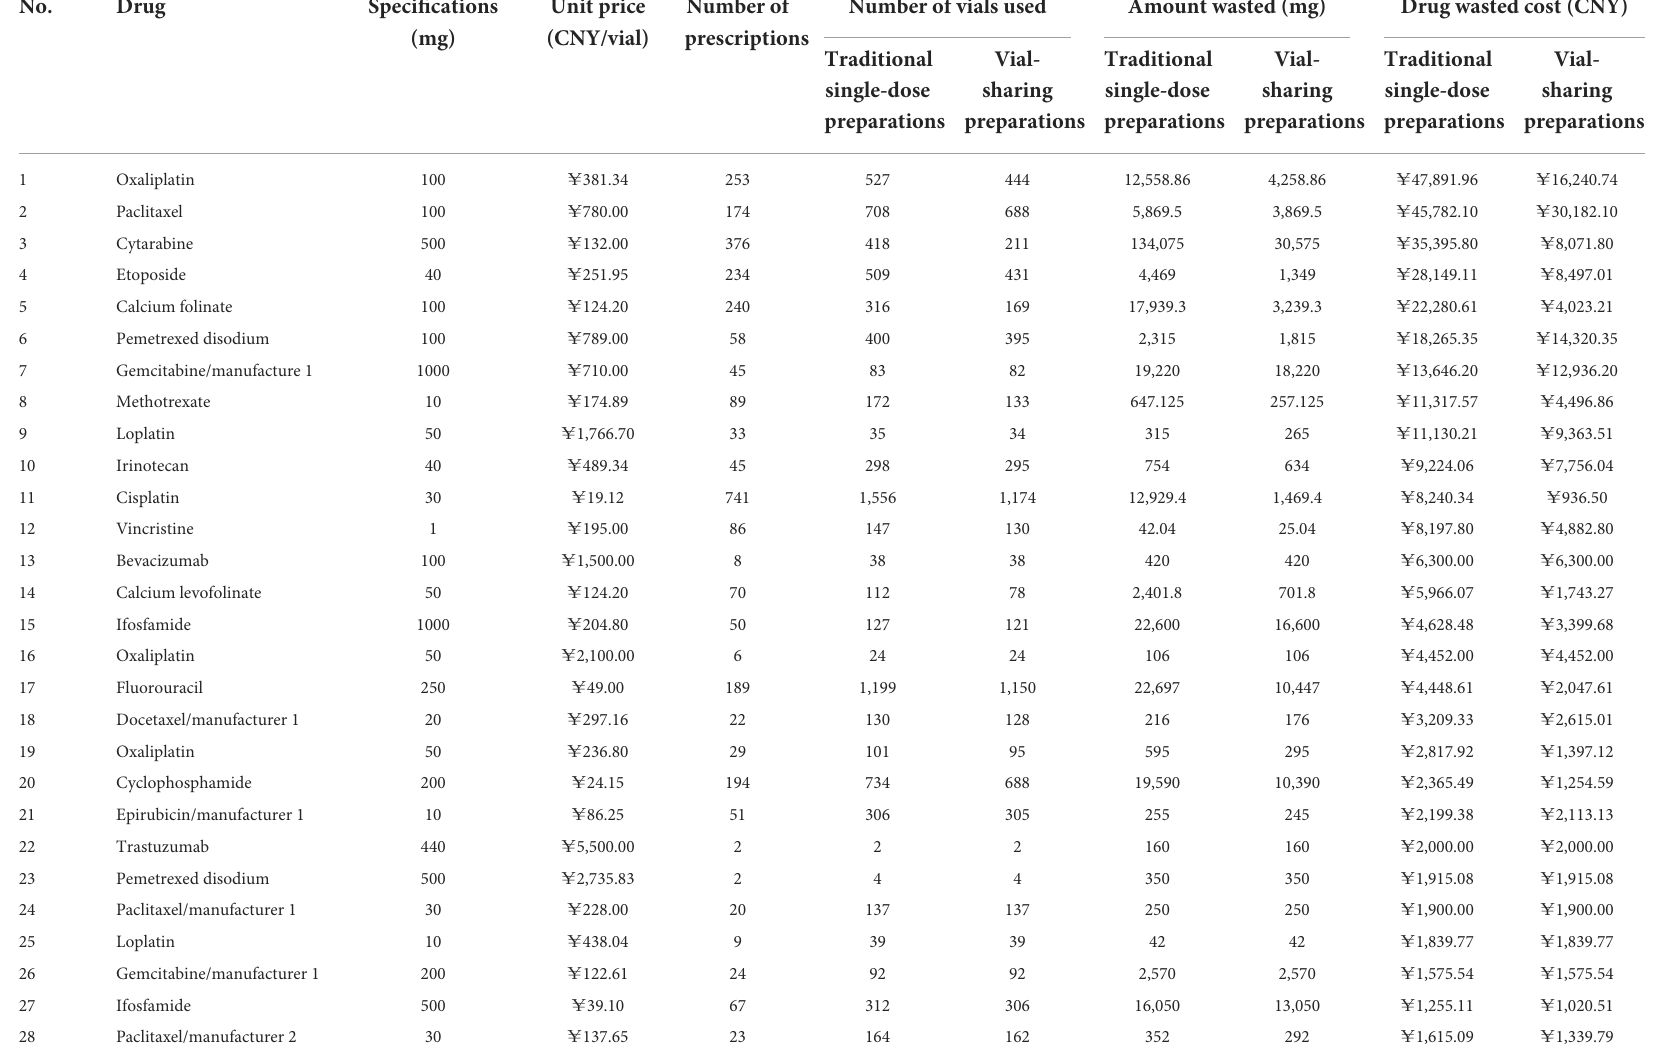
TABLE 3 Summary of information on waste-generating prescribed chemotherapy drugs at PIVAS.